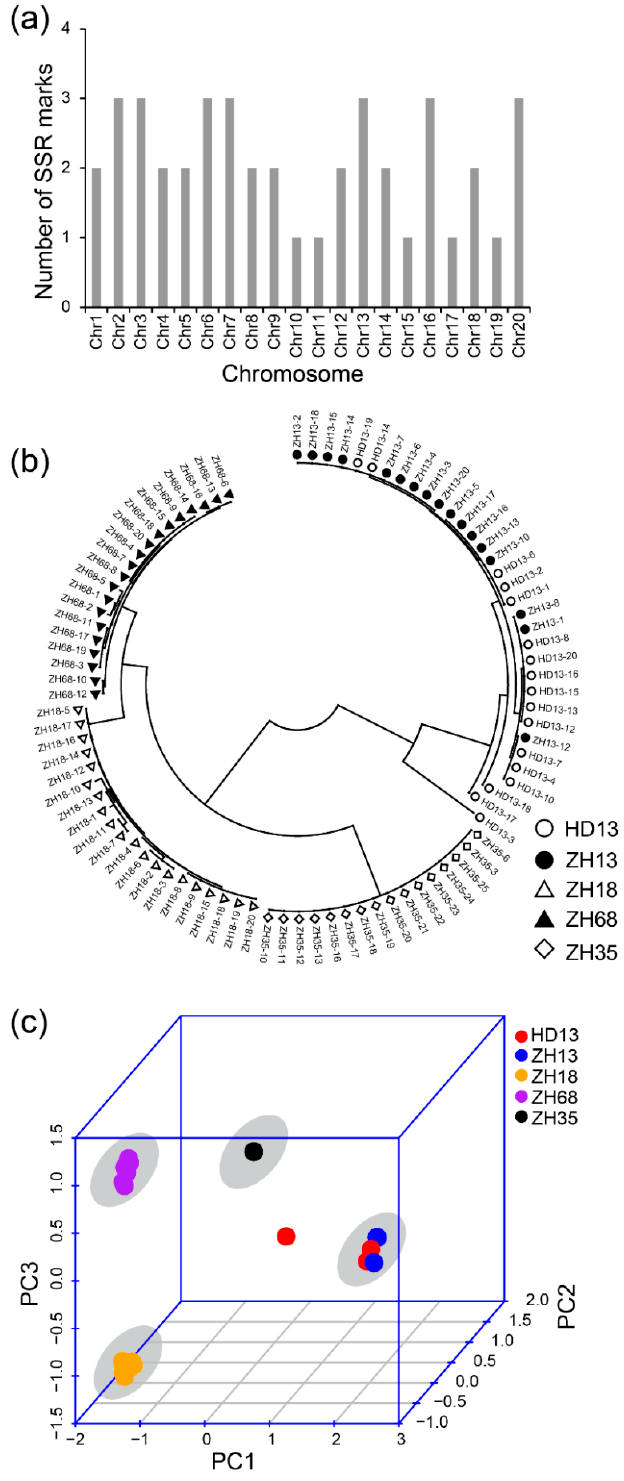
Figure 3. Identification of five soybean cultivars based on the polymorphism of SSR markers. ( a ) The distribution of SSR markers in soybean chromosomes; ( b ) The phylogenetic tree of all soybean plants. White circles represent cv. Hedou 13 (HD13), black dots represent cv. Zhonghuang 13 (ZH13), white triangles represent cv. Zhonghuang 18 (ZH18), black triangles represent cv. Zhonghuang 68 (ZH68), white diamonds represent cv. Zhonghuang 35 (ZH35); ( c ) The principal component analysis. Red: HD13, blue: ZH13, orange: ZH18, purple: ZH68, black: ZH35. The grey circle indicates the cluster of the cultivar.